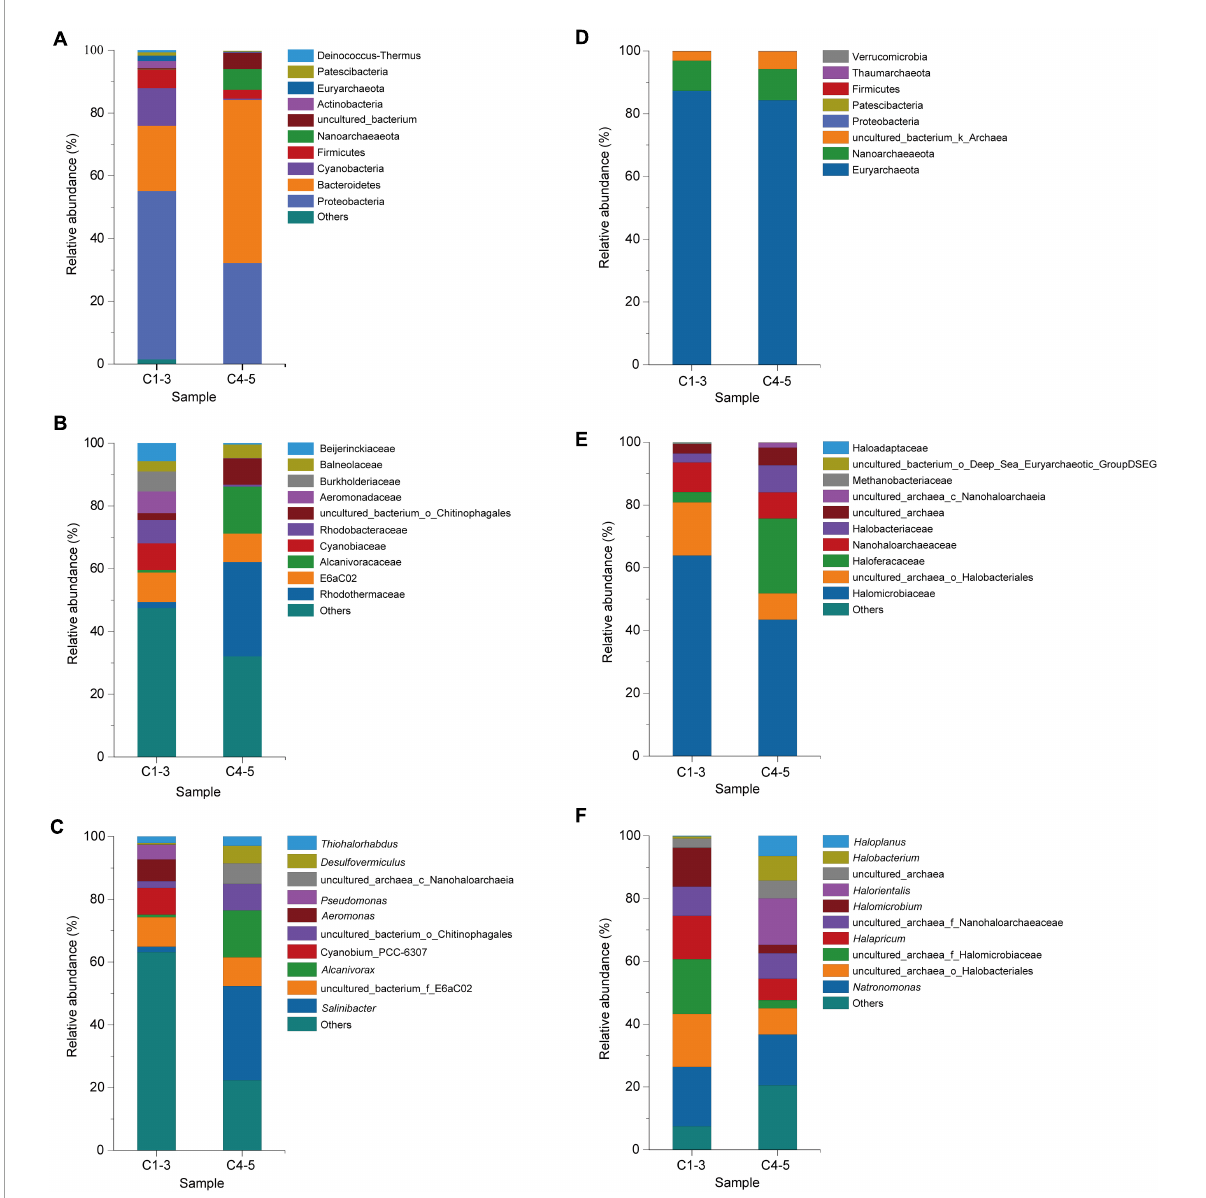
FIGURE4 Microbial community of brine samples revealed by 16S rRNA gene sequencing under culture-independent strategy. The community composition of bacteria in brine samples was shown at the phylum (A) , family (B) , and genus (C) levels; while composition of archaea in the brine samples was also shown at the phylum (D) , family (E) , and genus (F) levels; C1-3, three brine samples collected in July 2021; C4-5, two brine samples collected in August